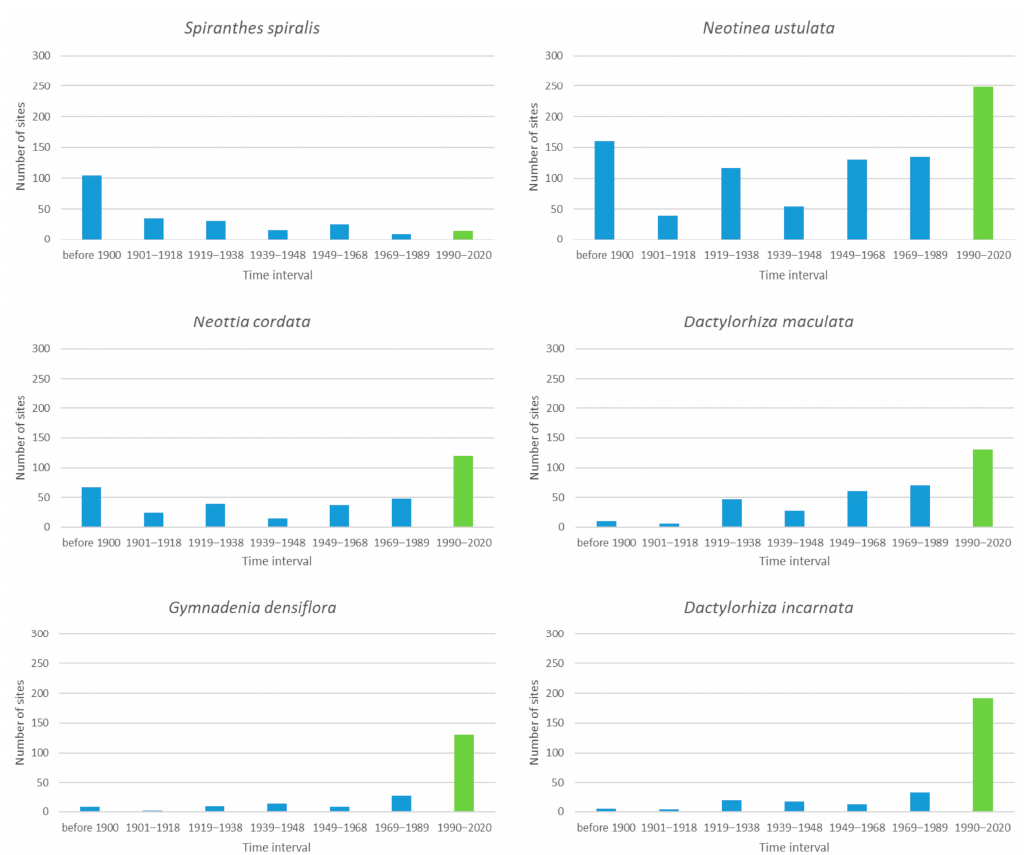
Figure 4. The number of sites that were occupied by orchids for the last time during the given interval and then were no longer occupied for the six species that were found historically at 101 to 300 sites. The green bar indicates the number of sites observed as extant in the last interval, which we consider as extant currently.